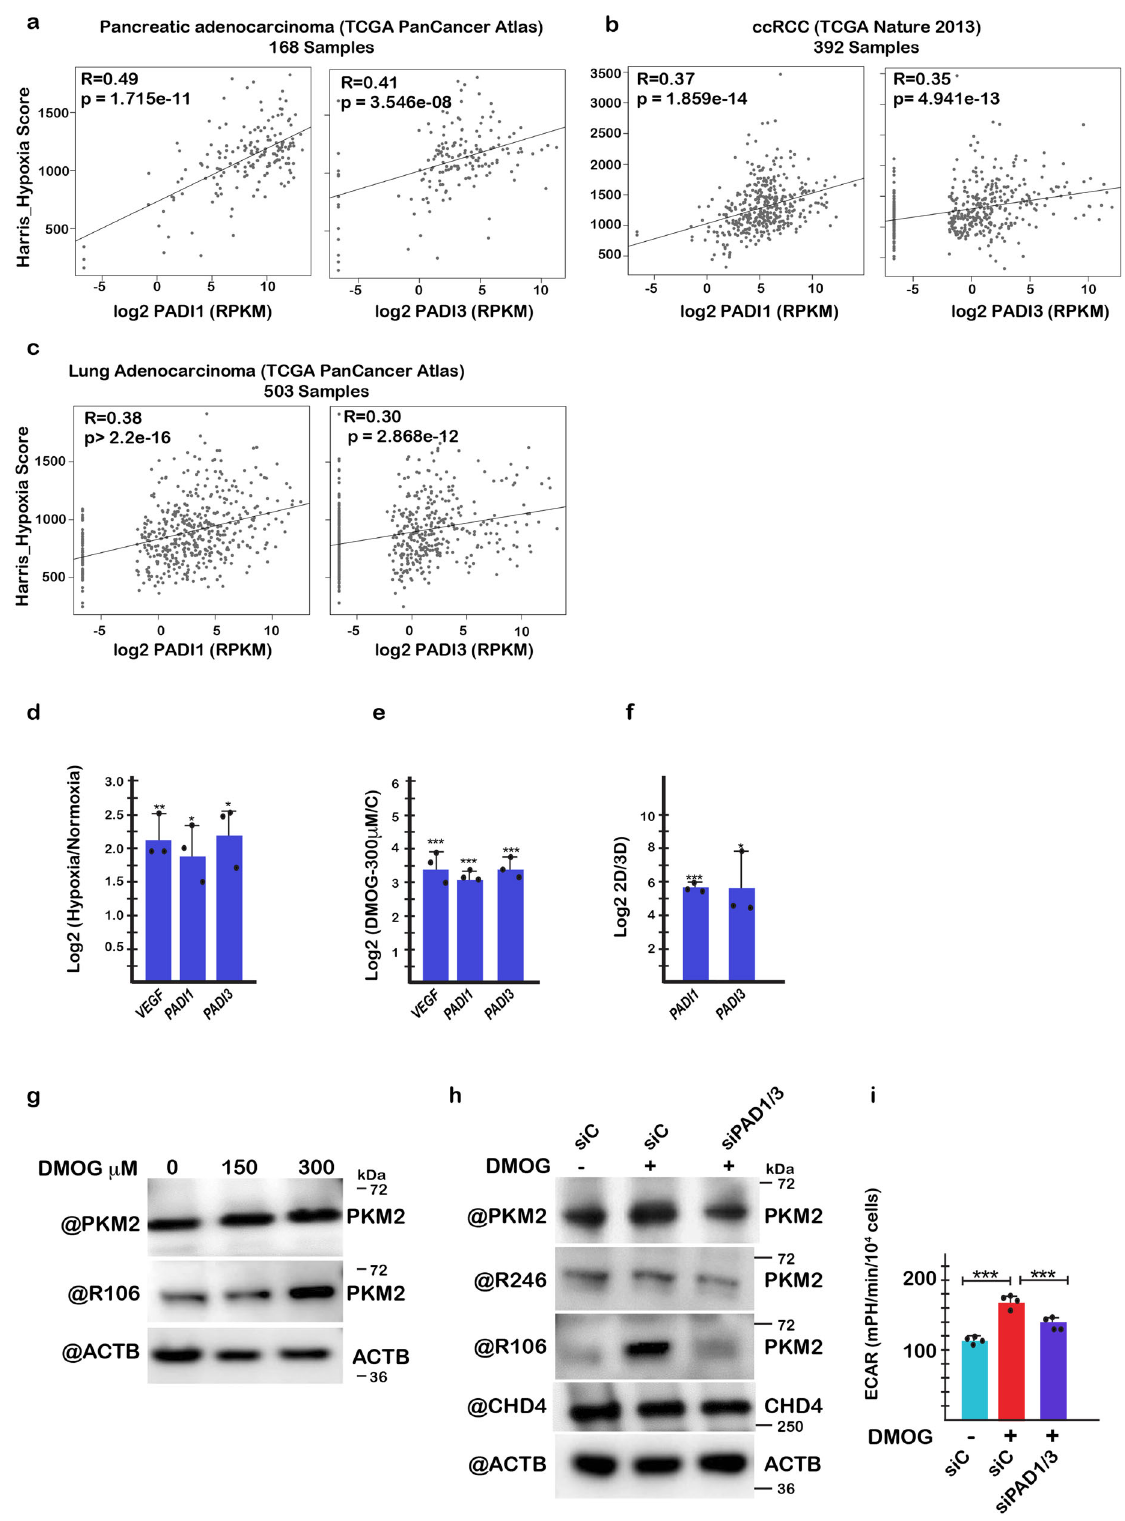
Fig. 7 PKM2 citrullination contributes to increased glycolysis in hypoxia. a – c Correlation of PADI1 and PADI3 expression with that of the HARRIS_HYPOXIA signature in the indicated cancer types using TCGA data sets. The Spearman correlations and p -values are indicated. d , e Expression of the indicated genes assessed by RT-qPCR in cells grown under hypoxia (1% O 2 ) ( d ) or pseudo-hypoxia with 300 μ M DMOG ( e ). n = 3 biological replicates. f Induction of PAD1 and PAD3 expression in 501Mel cells grown as 3D melanospheres for 7 days. g Immunoblots showing enhanced PKM2 R106Cit when grown under increasing concentrations of DMOG. h Immunoblots showing expression of the indicated proteins in transfected cells in presence of 300 μ M DMOG. i Glycolysis in transfected cells in presence of 300 μ M DMOG. ECAR values were determined from n = 4 biological replicates with 6 technical replicates for each N and unpaired t -test with two tailed p -value analyses and con fi dence interval 95% were performed by Prism 5. p -Values: * p <0.05; ** p <0.01; ***p <0.001. Data are mean ± SEM.